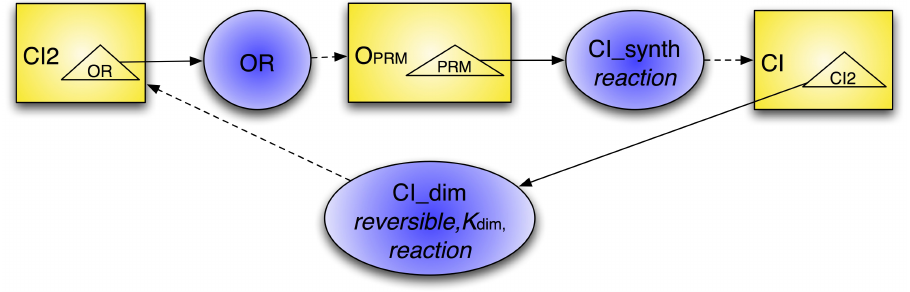
Figure 2: A MIN model representing the CI protein synthesis from the CI gene O PRM together with the CI protein dimerisation and the regulation of the CI gene O PRM by the CI dimer CI 2 through the regulatory site OR